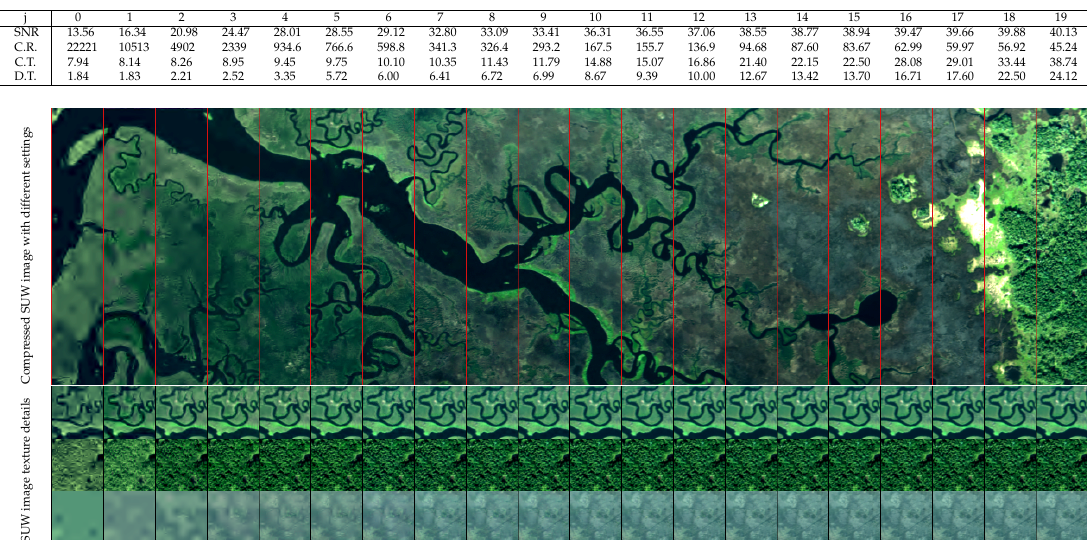
Figure 8. Table shows compression results of the SUW image compressed with F j configuration for each j shown. From top to bottom, rows are SNR, compression ratio (C.R.), compression time in seconds (C.T.) and decompression time in seconds (D.T.). The first image shows different parts of the SUW image, while the second image focuses on a comparison of three different spots with distinct textures.